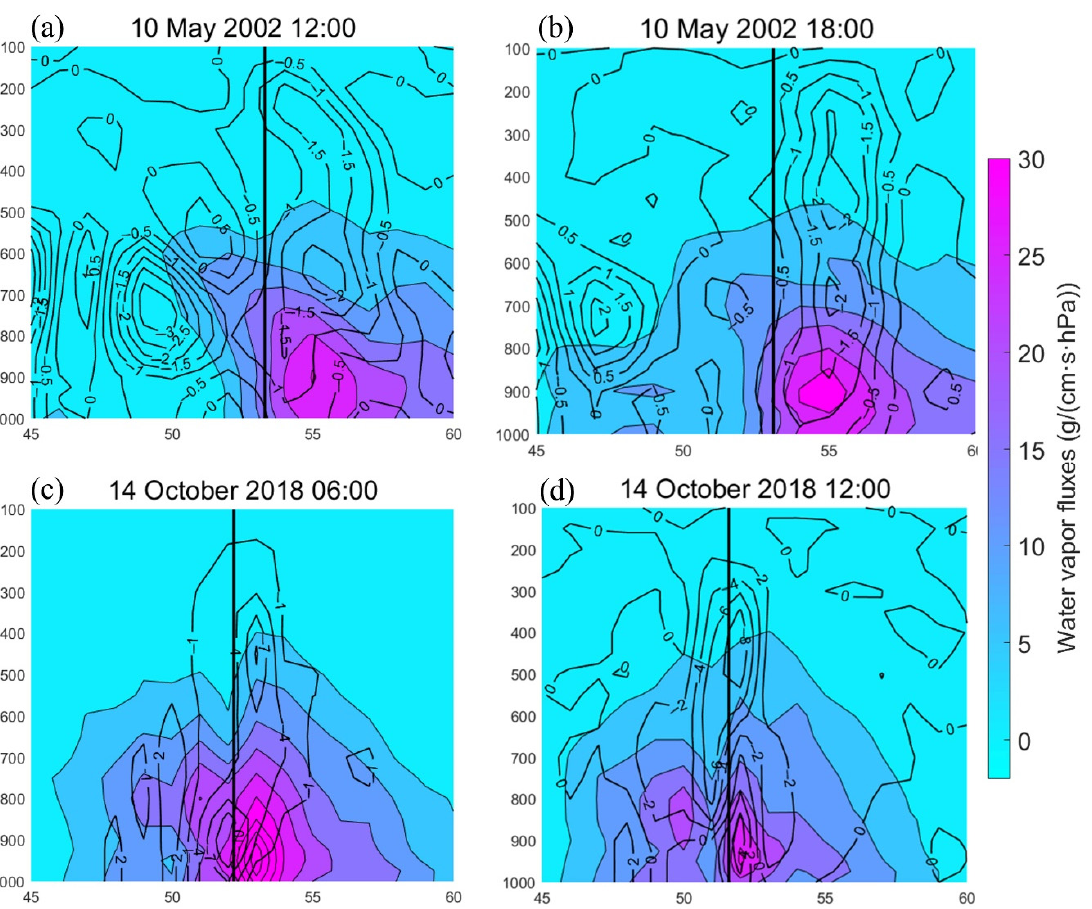
Figure 13. Meridional profiles of WVF and vertical velocity during and after landfall of ARB 01 on ( a ) 10 May 2002 12:00, ( b ) 10 May 2002 18:00, and Luban at landfall on ( c ) 14 October 2018 06:00, and ( d ) 14 October 2018 12:00.